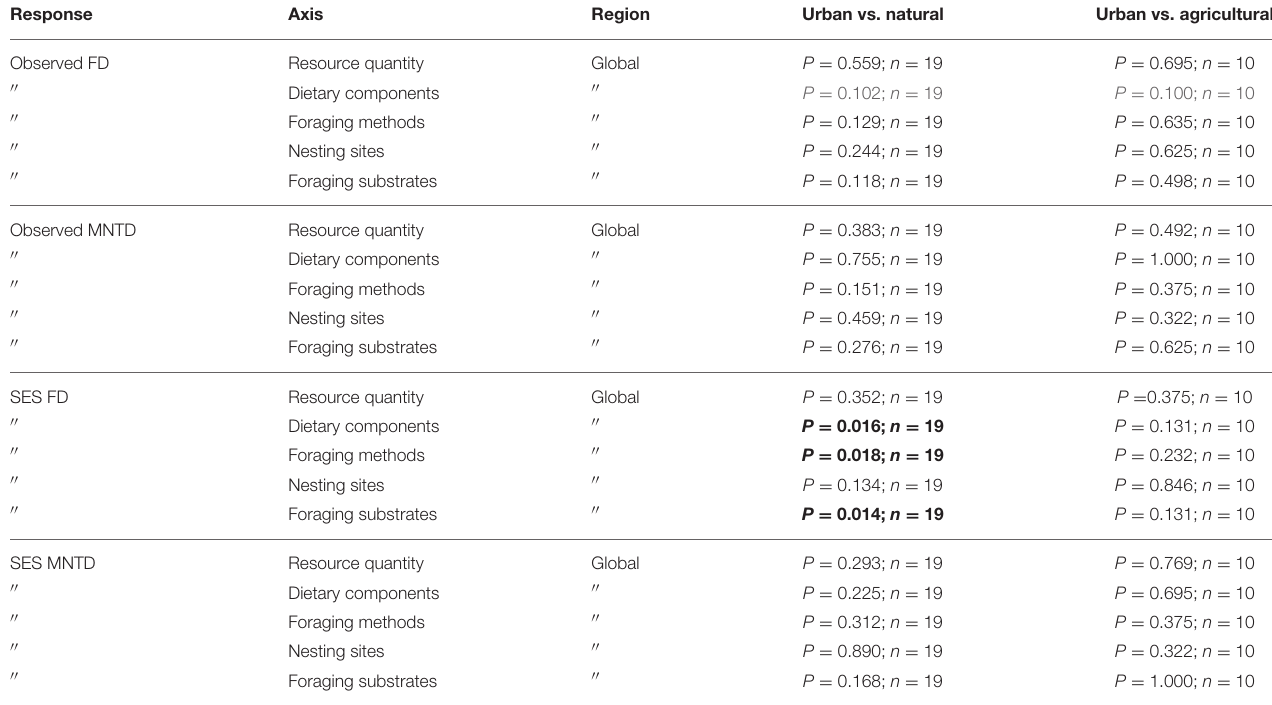
TABLE 3 | Results of paired tests for differences in species richness, observed functional diversity metrics, and standardized effect size (SES) functional diversity metrics that take species richness into account between paired urban avian assemblages and those in natural habitats, and between paired urban and agricultural assemblages.